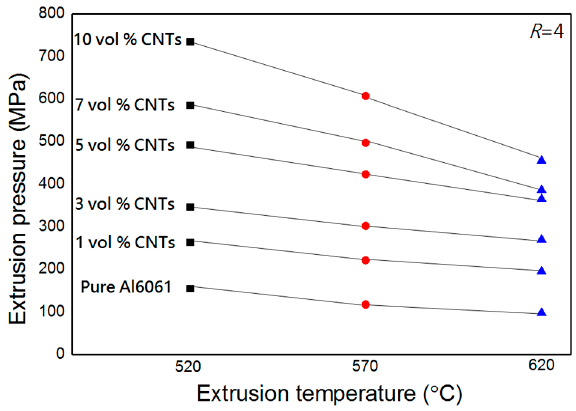
Figure 8. Extrusion pressure according to extrusion temperature and CNT content.